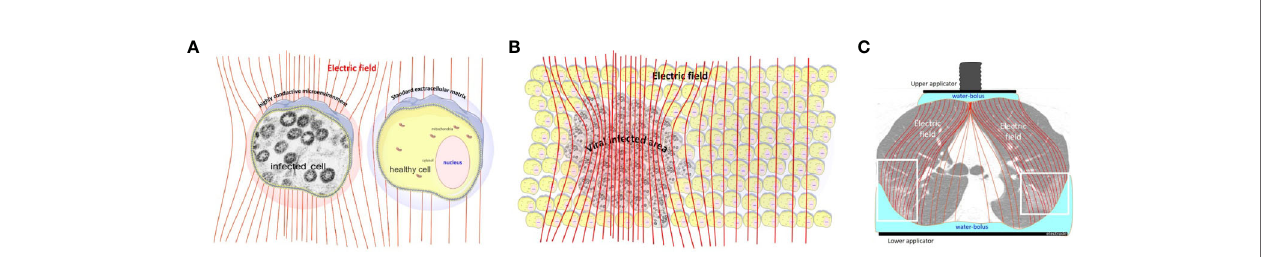
FIGURE 2 | The radiofrequency current fl ows into the direction of the lower impedance. (A) The increased metabolic activity of the infected cells allow lower impedance (higher conductance) in their microenvironment than in the healthy cells. (B) The electric fi eld selects the volumes with a high concentration of the infected cells. (C) the lung-lesions are loaded more with the radiofrequency current than the non-infected parts [The CT picture is from (74)].